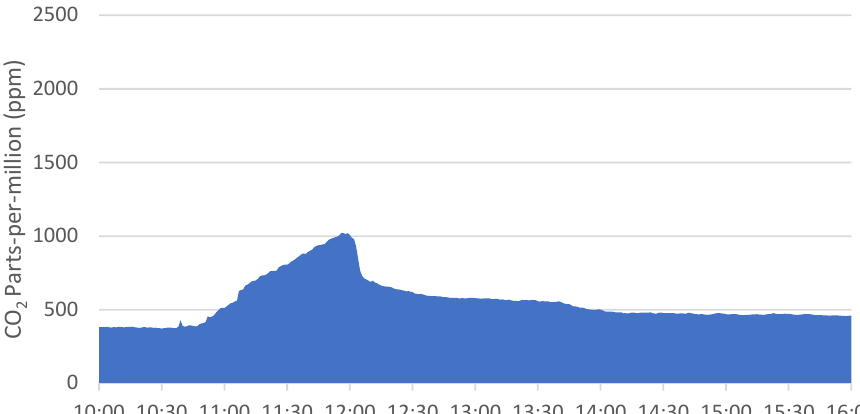
Figure 11. Test B: Full attendance classroom with ventilation.